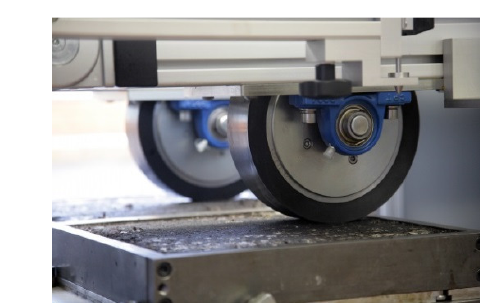
Fig. 3. Test equipment for wheel tracking test